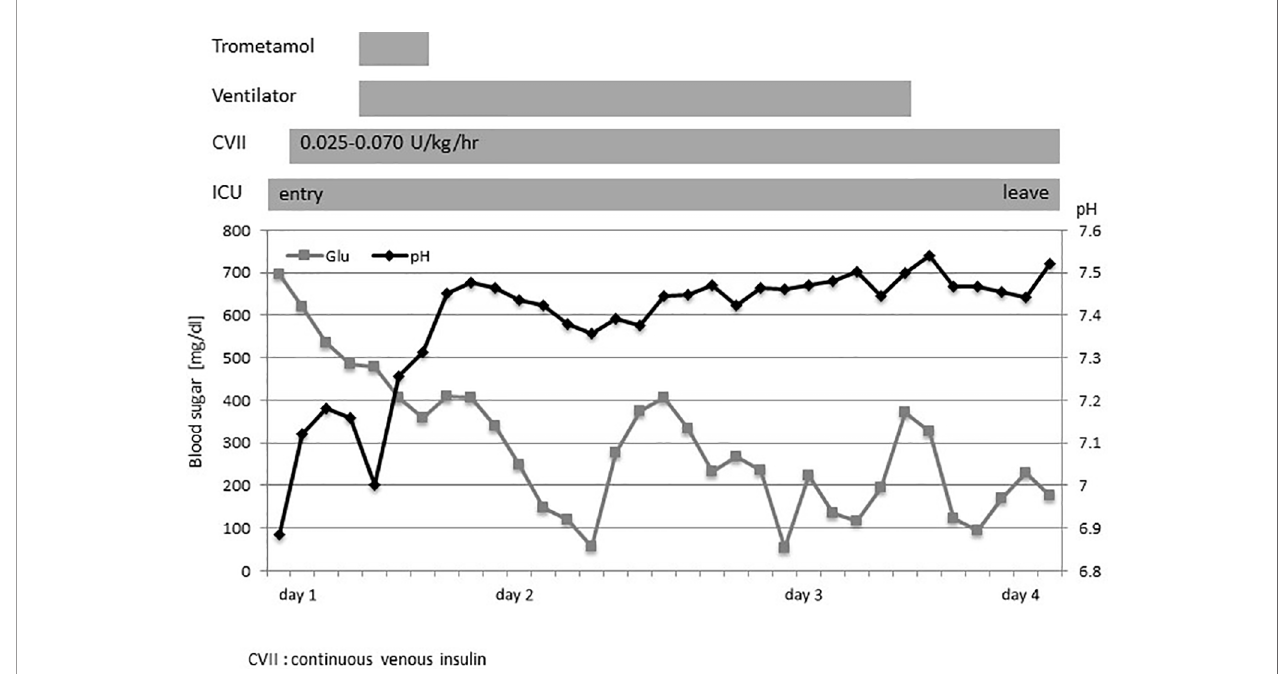
FIGURE 1 | The clinical course at admission. The clinical course and changes in the blood sugar level ( ◼ ) and pH ( ◆ ). CVII, continuous venous insulin; ICU, intensive care